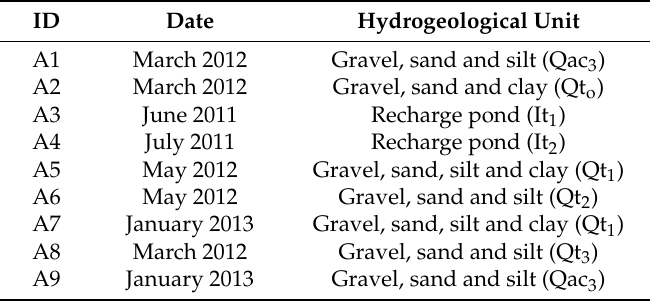
Table 2. Infiltration tests conducted at Cubeta de Sant Andreu